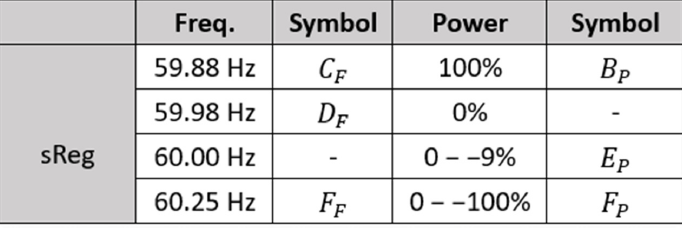
Figure 3. The response table of the sReg mode.